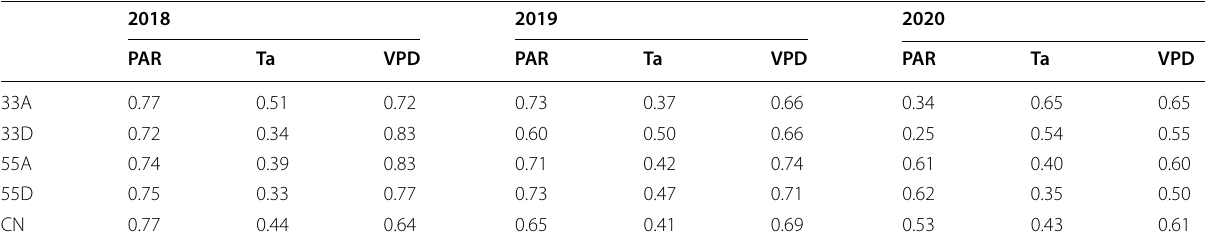
Table 2 Correlation coefficients ( R 2 values) describing the linear relationship between daily average sap flux density and daily average PAR, Ta and VPD ( p <